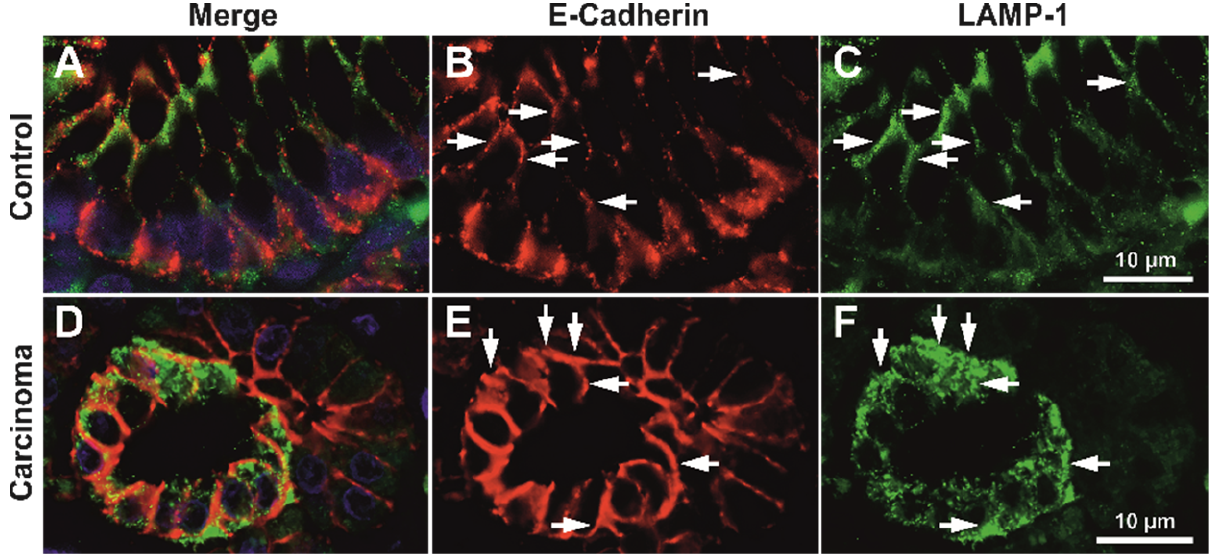
Figure 4. Exemplary deconvoluted images of double immunofluorescence for E-cadherin and LAMP1. On both control ( A – C ) and adenocarcinoma ( D – F ), images show colocalization of the two markers at both membrane and cytoplasmic levels. Colocalizations are indicated (arrows) at both membrane and sub-membrane cytoplasmic levels. Scale bar for images A–C and D–F, 10 μ m.